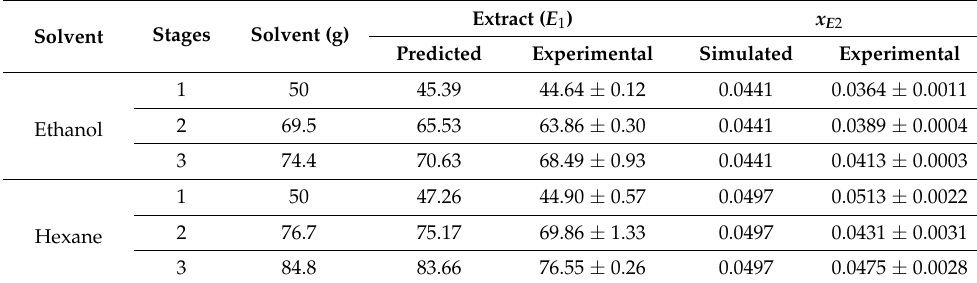
Table 3. Experimental and predicted E 1 and x E 2